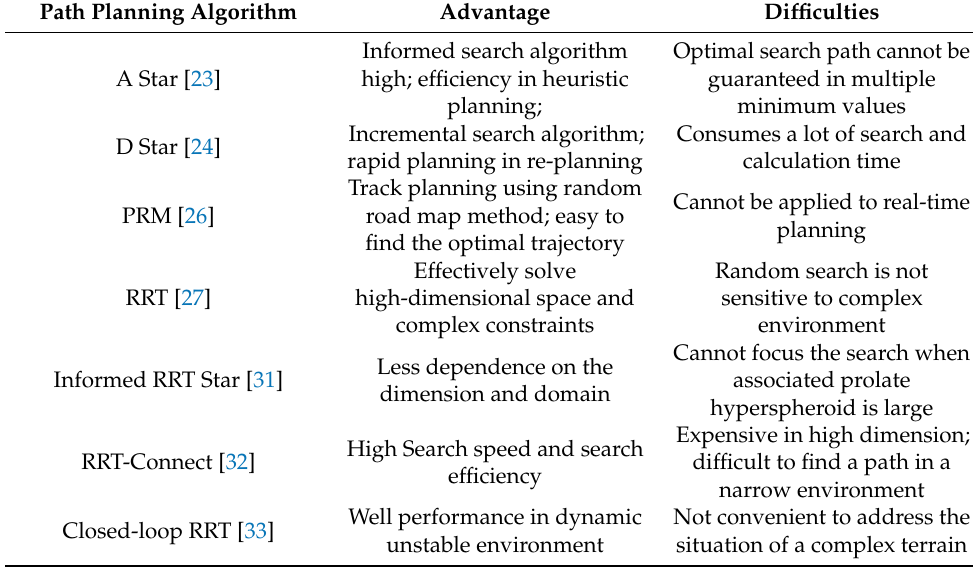
Table 2. The main used path planning methodologies with each advantage and